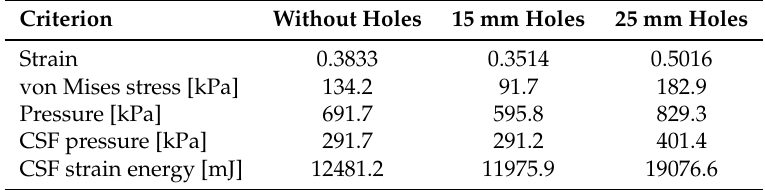
Table 12. Comparison of head injury criteria computed with YEAHM for AC216